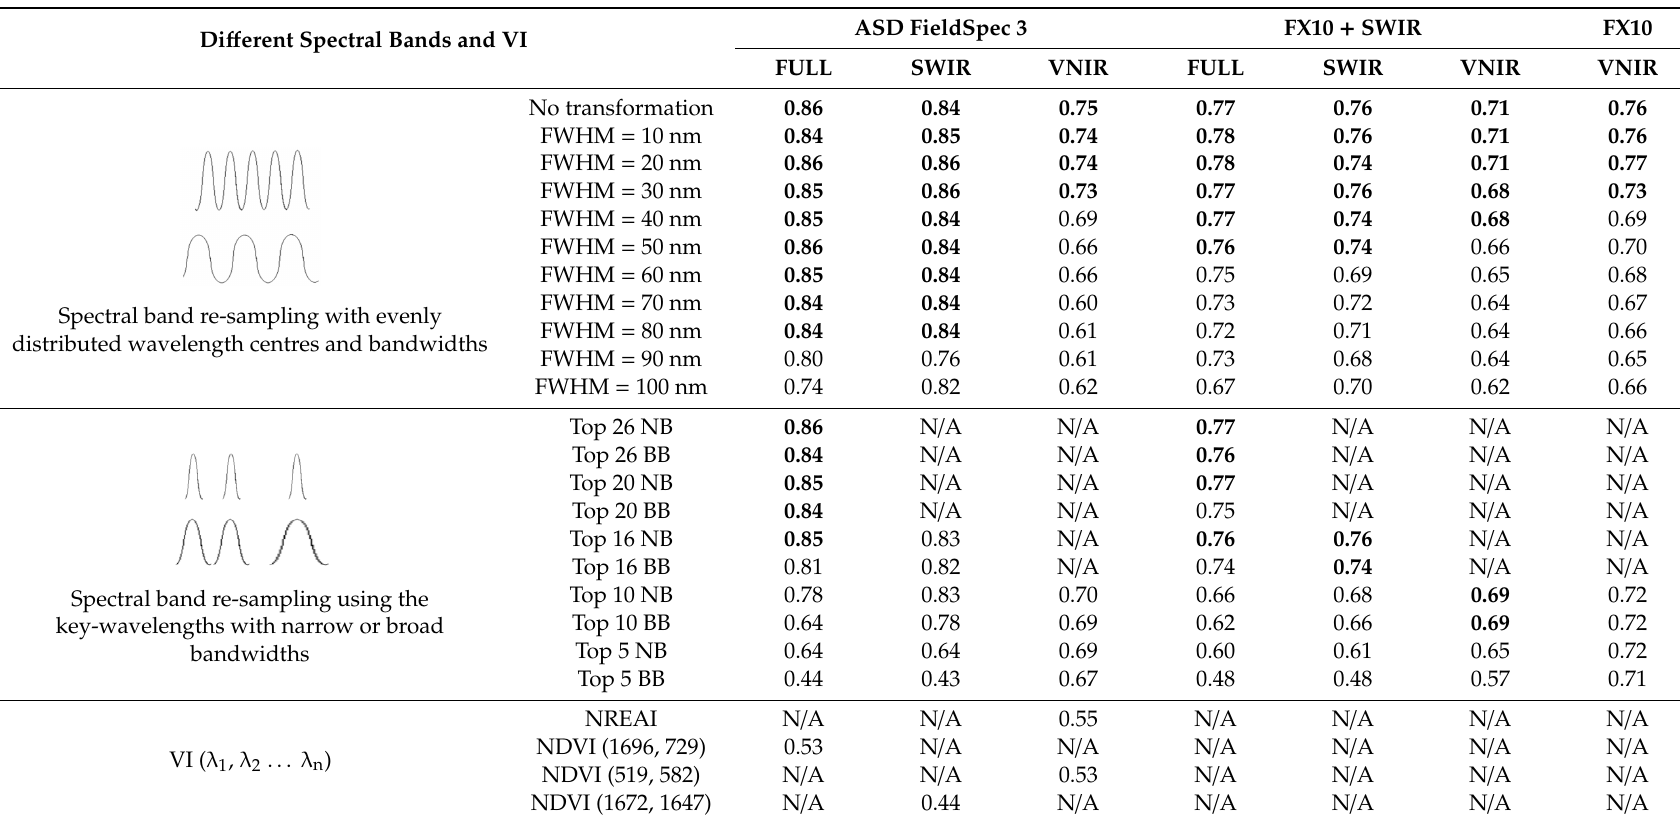
Table 1. The average R 2 for validating the PLSR models. The rows include three sections. The first section demonstrates the results of the models built from the original data and the spectrally re-sampled data with even wavelength distances and full width at half maximum (FWHM). The second section lists the results of the models using only the key ‐ wavelengths, including both narrow bandwidth (NB) and broad bandwidth (BB). The third part shows the regression results of some well-known VIs. The bold fonts highlighted the top three R 2 values in corresponding sensors and wavelength ranges. N / A stands for “not available”.